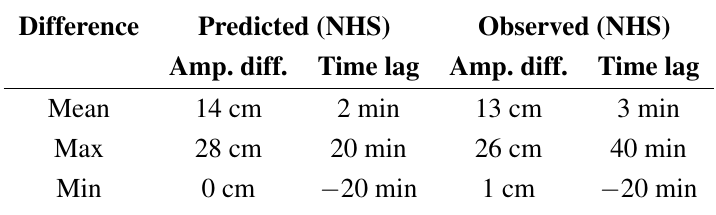
Figure 7. Comparison of the calculated tidal range between received data from the NHS and measured ADCP tidal level data. R 2 = 99%. Black dots show the flood tidal range, and red dots the ebb tidal